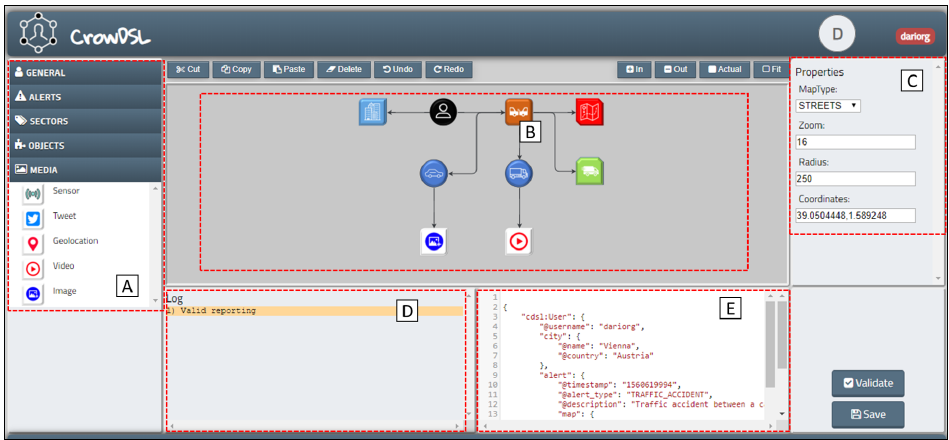
Figure 2. CrowDSL Web editor.